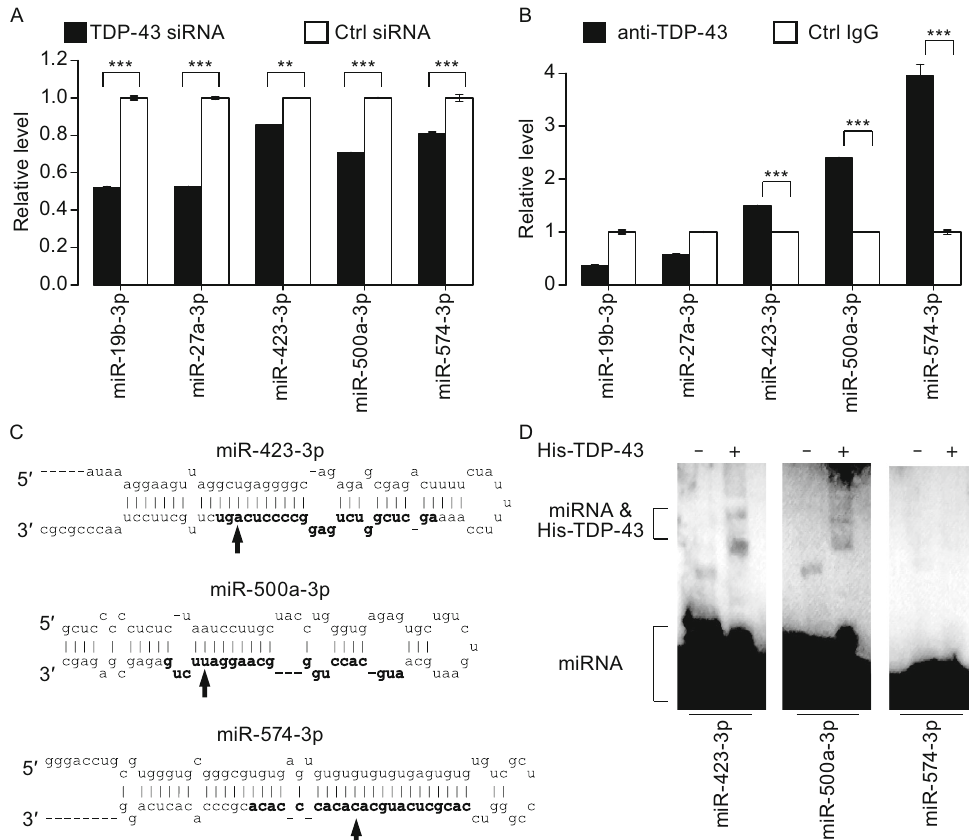
Figure 4. Identi fi cation of TDP-43 binding miRNAs. (A) Changes of expression levels of 5 miRNAs after TDP-43 knockdown in SH-SY-5Y cells. Relative miRNA levels were determined by qRT-PCR ( n = 3; means ± SEM; ** P < 0.05; *** P < 0.01). (B) Association between endogenous miRNAs and TDP-43. RNA Immunoprecipitation (RIP) enrichment was determined as miRNAs associated to TDP-43 IP relative to control IgG ( n = 3; means ± SEM; ** P <0.05; *** P <0.01). (C) TDP-43 binding sites in 3 different miRNAs. The secondary structures of the pre-miRNAs are shown, mature miRNAs sequences in bold. Predicted TDP-43 binding sites in the mature miRNAs are indicated by arrows. (D) Electrophoretic mobility shift assay (EMSA) with recombinant His-TDP-43 protein and biotin- labeled mature miRNA sequences. miR-423-3p (left), miR-500a-3p (middle), and